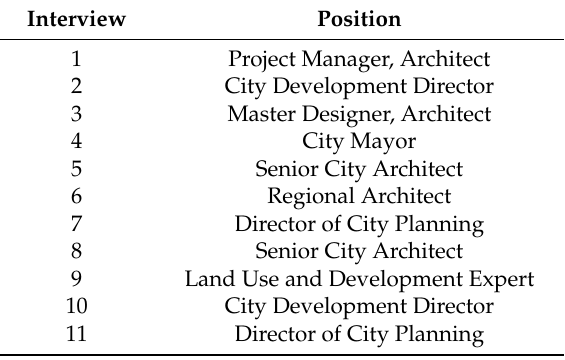
Table 3. Interviewees by their professional